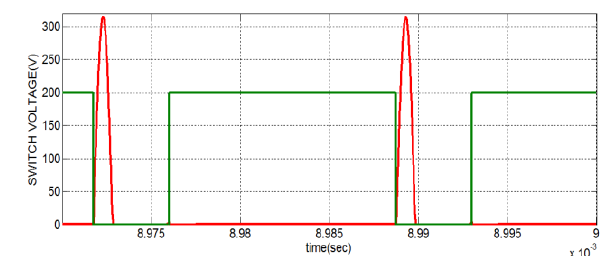
Fig. 13. Switch voltage vs. duty